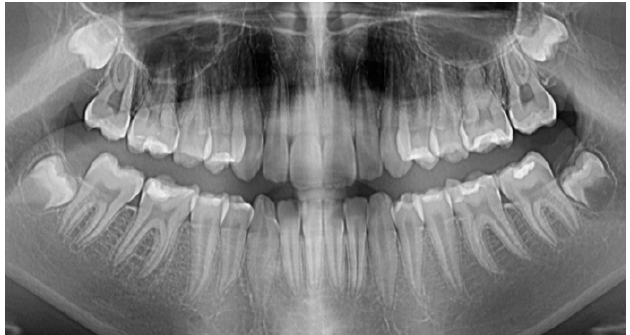
Figure 2. Initial radiographic investigation.